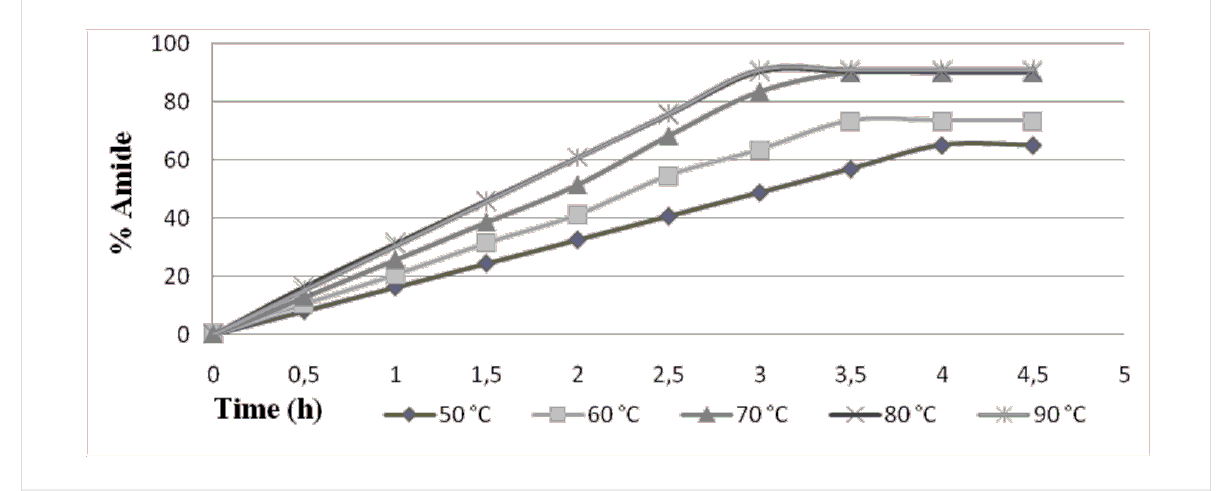
Figure 2: Effect of the temperature using equimolar ratio and 20 mg of enzyme.